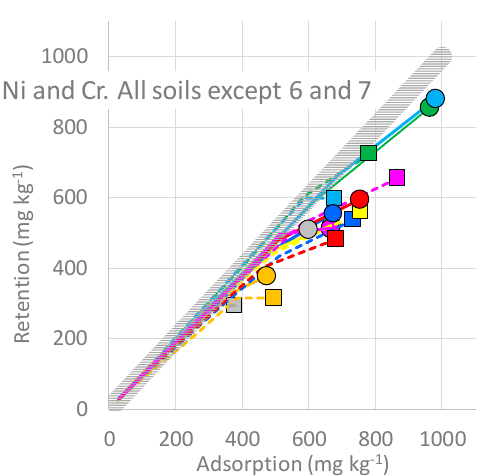
S6 : circles show the highest retention/adsorption ratio and continous line the rest of the concentrations. S7 : squares show the highest retention/adsorption ratio and dotted lines the rest of the concentrations. Cu : green. Zn : dark yellow. Pb : grey. Ni : light blue. Cr : red.